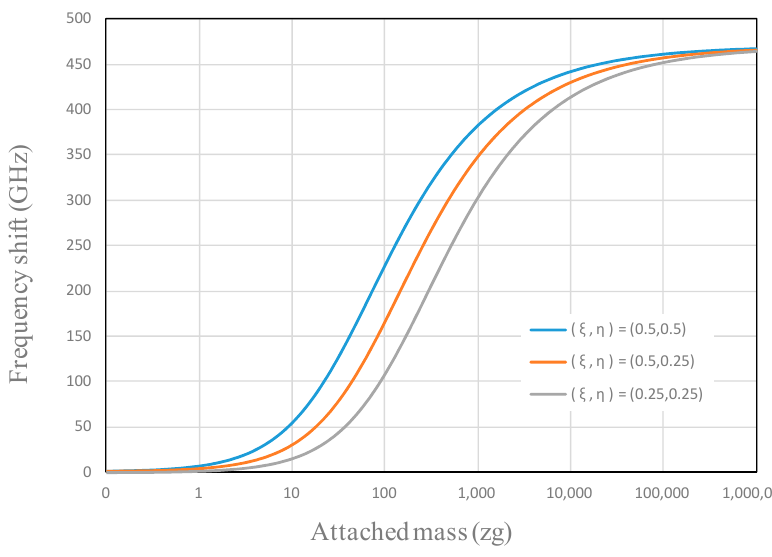
Figure 2. Location influence of the attached nanoparticle on the frequency shift of single-layer graphene sheets (SLGSs) ( e 0 a = 2.0 nm, Δ T = 100 K).